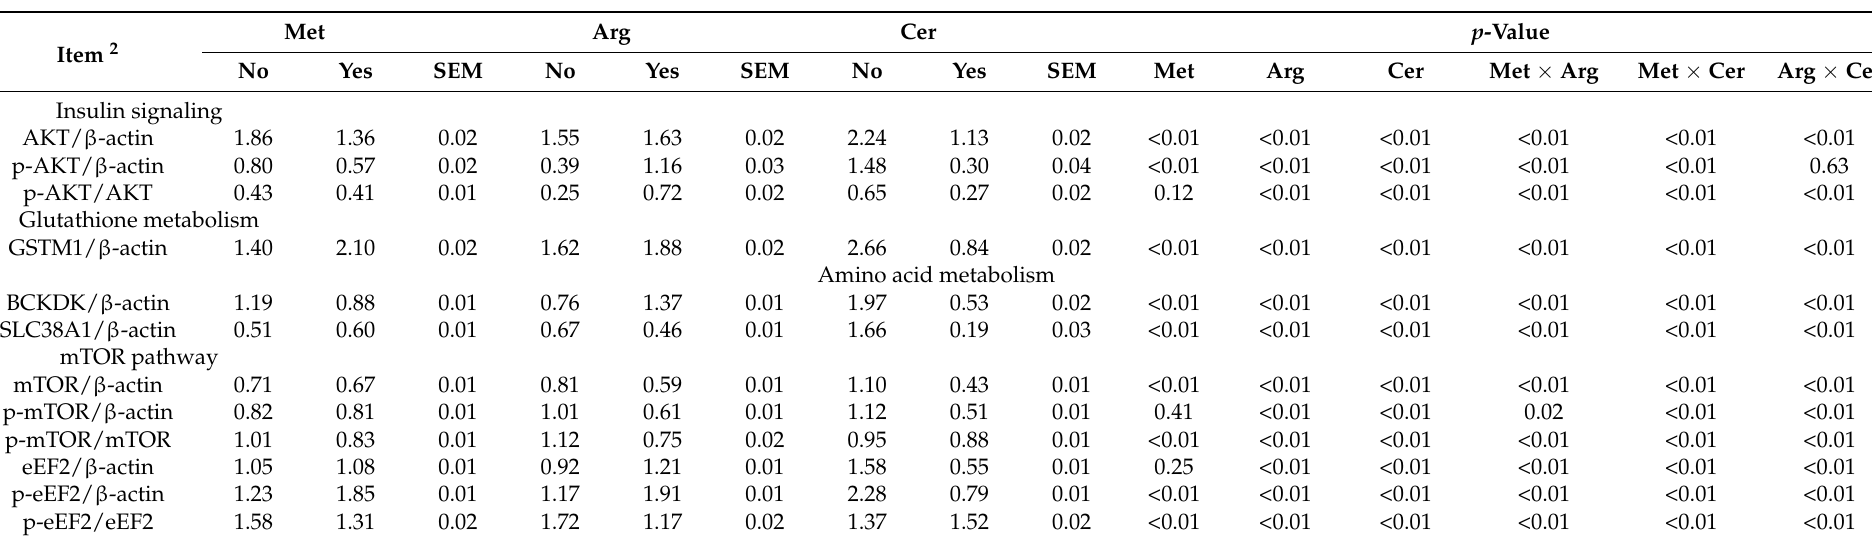
Table 2. Abundance of proteins (relative to β -actin) related to the mechanistic target of rapamycin (mTOR) and insulin signaling pathways in subcutaneous adipose tissue cultured with different levels of Met or Arg and challenged with ceramide 1